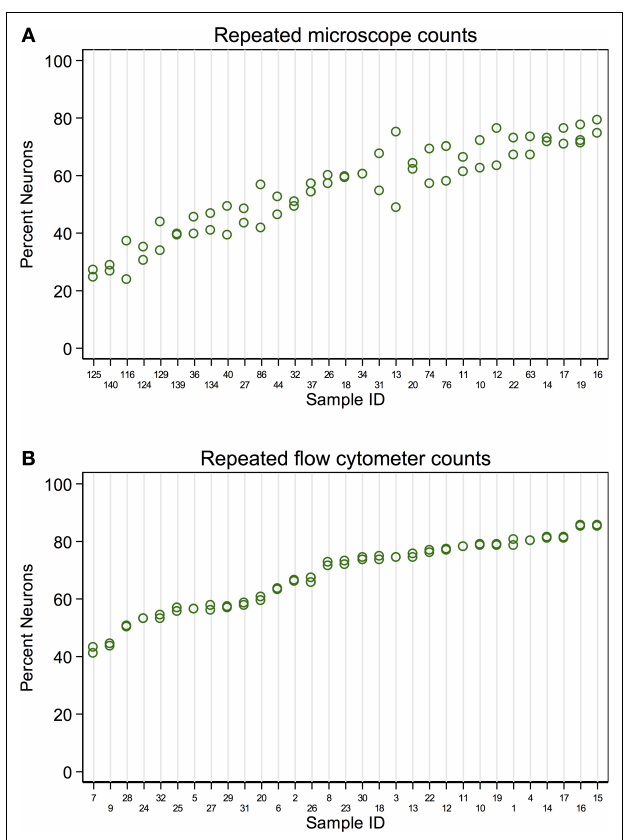
FIGURE 1 | Comparison of repeatability measures from the two different counting methods. (A) Microscope repeatability index plot. An index plot is shown, illustrating repeated counts on a fl uorescence microscope by a single human expert. The samples are ordered along the x -axis by ascending sample means. Each plot point is one count. Replicate counts are measures from the same sub-sample, thus each replicate count isolates the measurement error introduced at counting from any error that may be introduced in processing, but not staining. Thirty-one samples were counted, each at least 2 times (mean 2.2, range 2–4, 92 total observations). A random effects linear model estimated the standard deviation of repeatability as 6.11 (CI 4.78, 7.80). The standard deviation between samples was 14.09 (CI 10.68, 18.60). The intraclass correlation was 0.84 (CI 0.74, 0.94). (B) Flow cytometer repeatability index plot. The corresponding index plot for repeated counts by a fl ow cytometer is illustrated. Each replicate includes counting error only. Thirty-one samples were counted each two times (62 total observations). The standard deviation of repeatability was estimated, by a random effects linear model, to be 0.65 (CI 0.50, 0.83). The standard deviation between samples was 12.38 (CI 9.61, 15.95). The intraclass correlation was 0.99 (CI 0.995,